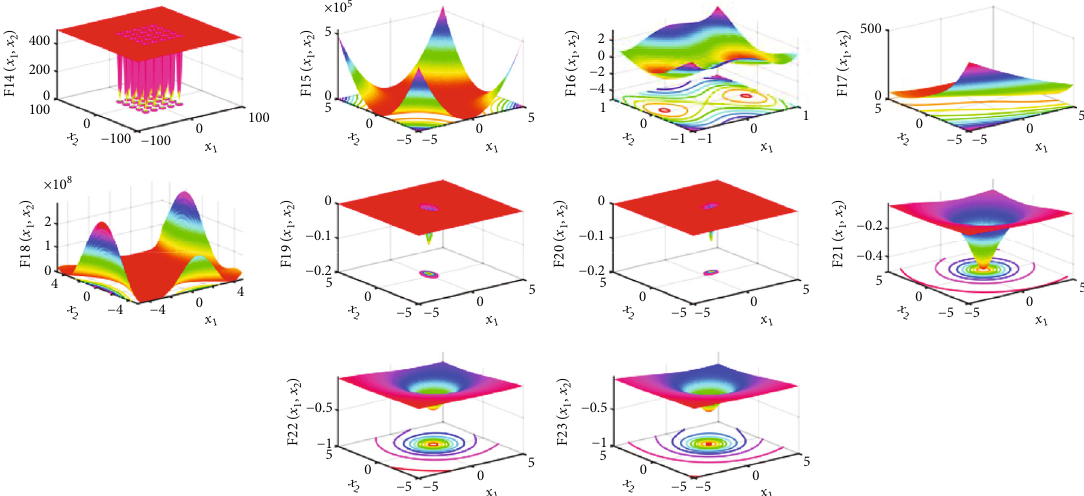
Figure 7: 2-D version of fi xed-dimension multi-modal benchmark functions.